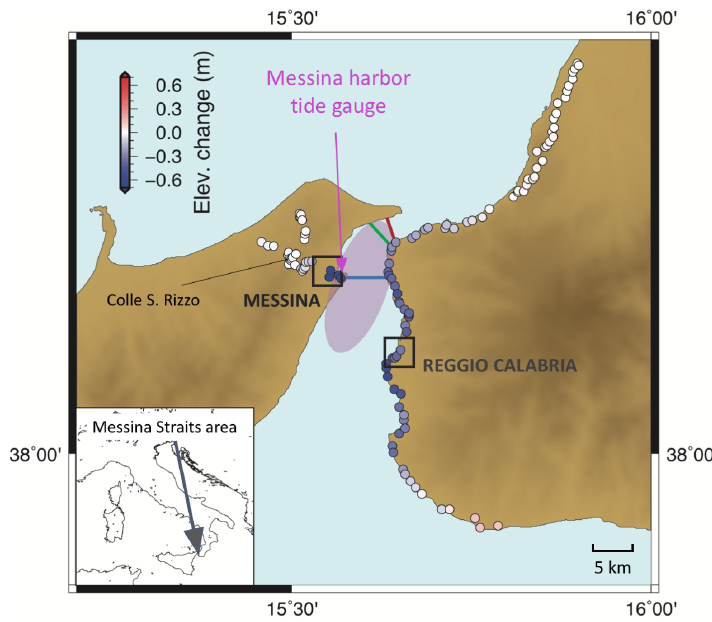
Figure 1. The Messina Straits area. The filled circles correspond to the benchmarks of the leveling lines (Loperfido, 1909), with the color scale indicating the measured elevation change while the pink shaded oval represents approximately the area of the 1908 earthquake pre- cursory subsidence larger than 0.4m, according to Barreca et al. (2021). The segments across the shores of the straits indicate the track of the alternative projects of connection between Sicily and Calabria, presently under evaluation: single-span bridge (red), multi-span bridge (green), and undersea tunnel (blue). The figure was partly generated with Generic Mapping Tools (GMT; Wessel and Smith,